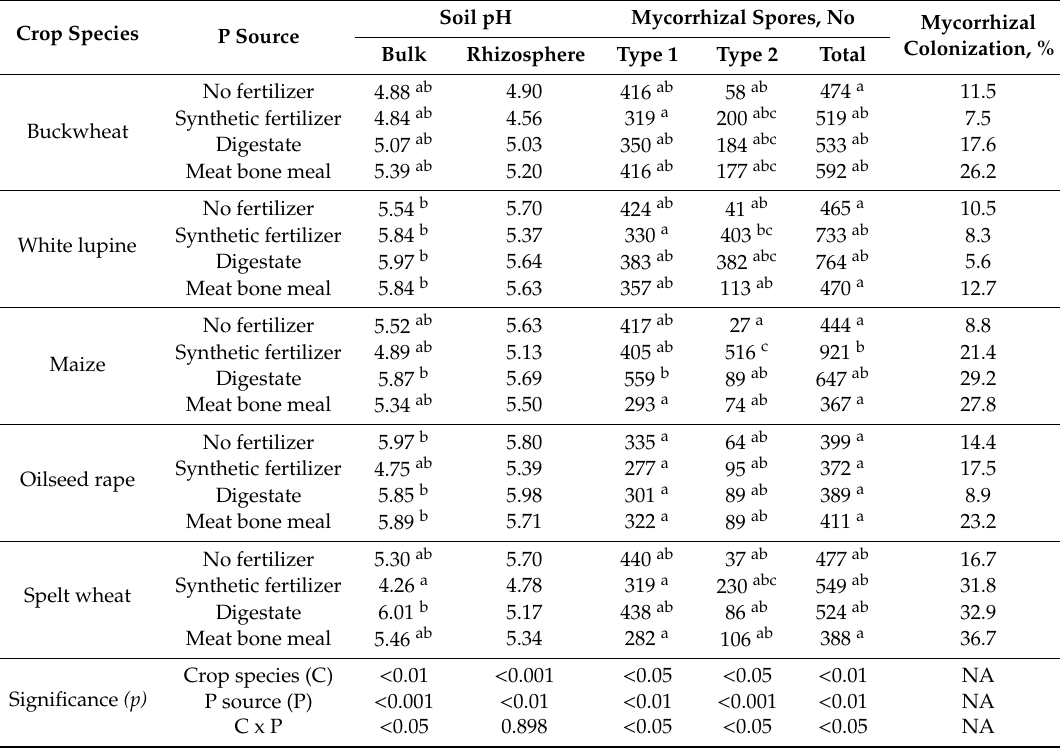
Table 2. Bulk soil and rhizosphere soil pH H2O , number of mycorrhizal spores in 10 g of rhizosphere soil, and the percent of root mycorrhizal colonization in the studied crop species grown under di ff erent P sources. Data are shown are means, n =